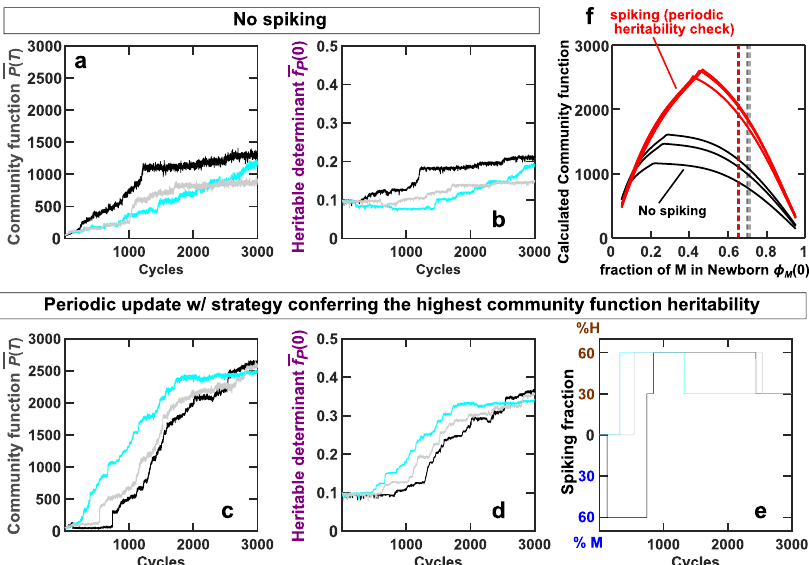
Fig. 7 Adjusting perturbation strategies based on periodic heritability check improves selection ef fi cacy even when the landscape is high-dimensional and unknown. Plots show the evolutionary dynamics of community function P ( T ) and the heritable determinant f P ð 0 Þ averaged over chosen communities under the no-spiking strategy ( a , b ) and under spiking strategy dictated by periodic heritability check ( c , d ). During the periodic check, community function heritability under fi ve candidate spiking strategies (no spiking, 30%-H spiking, 60% H spiking, 30% M spiking, and 60% M spiking) is evaluated every 100 cycles. The current strategy is replaced by an alternative strategy if the alternative strategy confers signi fi cantly higher heritability. Spiking mix consists of fi ve evolved H clones or fi ve evolved M clones randomly isolated from the same community lineage in the previous cycle. The corresponding spiking percentages determined by periodic check are displayed in ( e ). Black, cyan, and gray curves represent three independent simulation replicas. Due to the high-dimensional landscape, we can no longer determine the theoretical maximal community function. f Communities evolved under periodic heritability check (red) exhibit higher functions than communities evolved under no spiking (black). To compare communities evolved under these two strategies, we analyze communities with the highest functions in Cycle 3000 of simulations in ( a ) and ( c ), and plot their functions calculated using Equations (1 – 7) at various Newborn species ϕ M (0), based on their heritable determinants ( f P ð 0 Þ , g Mmax ð 0 Þ , K MR ð 0 Þ , etc.). We also calculated the steady state ϕ M from the same equations and plot them in vertical dashed